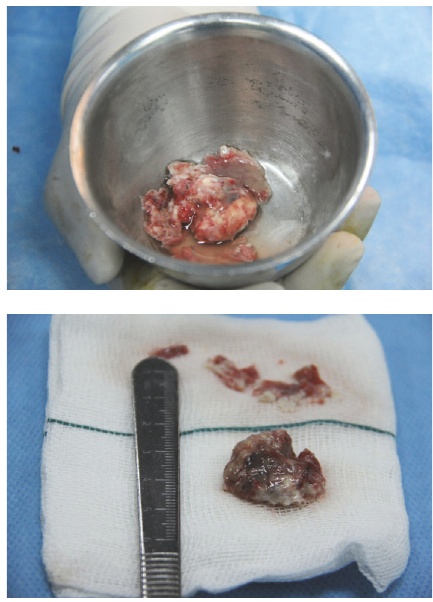
Figure 4: The complete excision of intracardiac mass